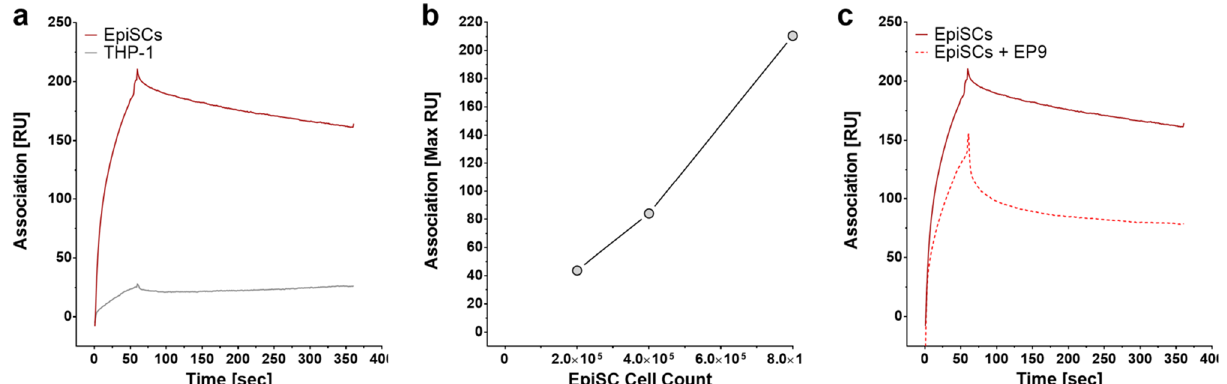
Figure 3. Surface plasmon resonance (SPR) of the EP9/EpiSC interaction: ( a ) EP9 was coupled to a BIAcore CM5 chip via the thiol coupling of C-terminal cysteine. EpiSCs, were flushed over the immobilized peptide EP9 and the binding was observed over a period of 60 s (Response Units = RU). Dissociation was induced after 60 s. by injection of buffer over the sensor chip and then dissociation was monitored over the following five min. As control, binding and dissociation of THP-1 monocytes (black curve) to immobilized EP9 was analyzed. ( b ) Impact of cell number on binding to EP9. Three different amounts of EpiSCs (200 × 10 3 , 400 × 10 3 , 800 × 10 3 ) were assessed. The relation of the maximum response unit versus cell concentration is shown. ( c ) Competition assay: overlay of the SPR sensorgrams for EpiSCs (red) and EpiSCs pretreated with EP9 (red-dashed) to block the interaction with the BIAcore-EP9